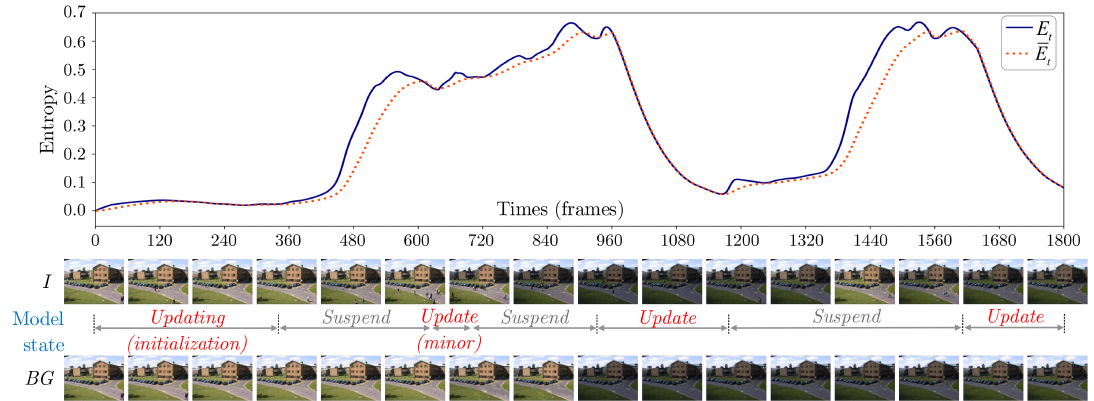
Figure 3. An illustration of adaptive threshold learning and dynamic scene adaptation with the image sequence Dataset3Camera1 in the motion detection challenge Illumination Changes from the IEEE Scene Background Modelling Contest